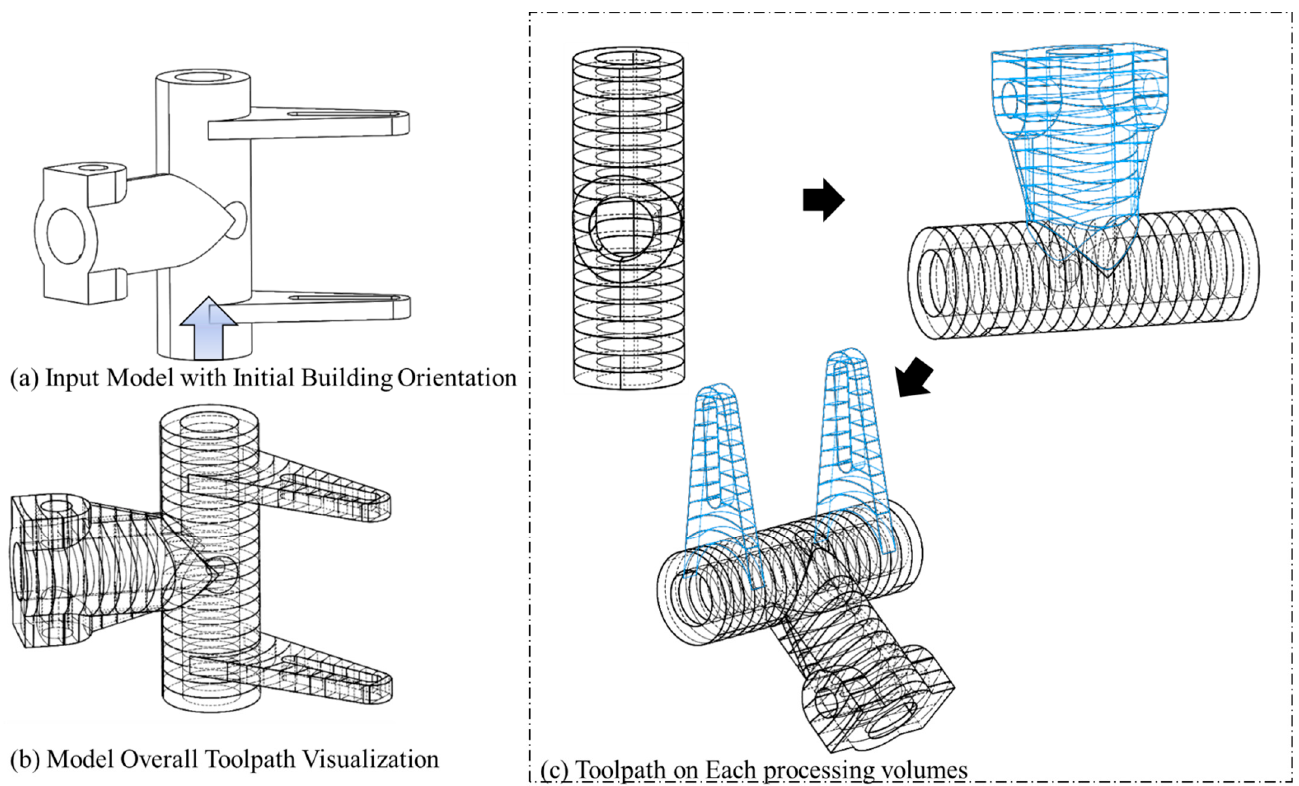
Figure 17. Trajectory accumulation on model with second defined initial building orientation for model (b).